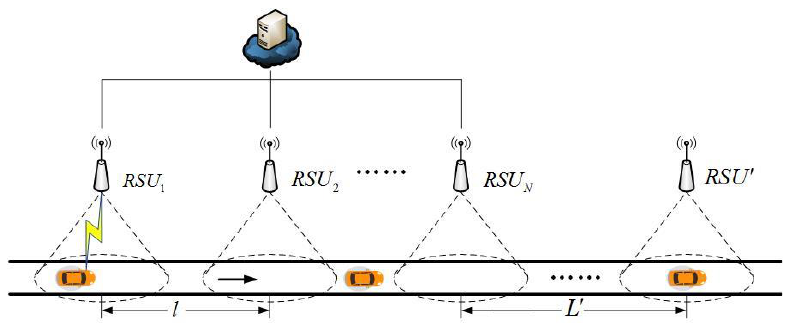
Figure 1. RSU packet scheduling for CVIS.